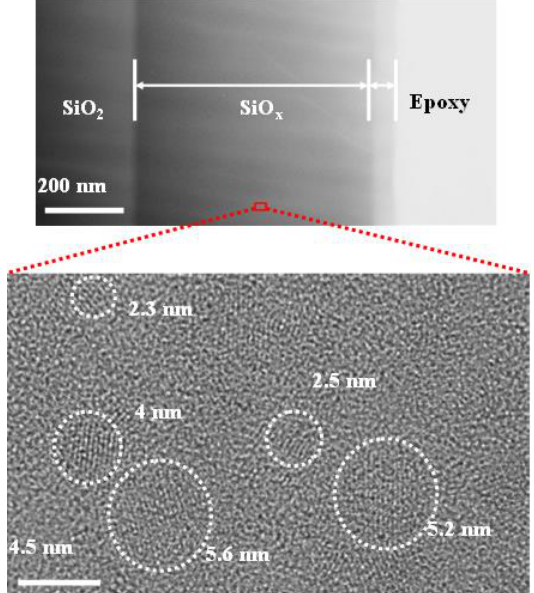
Figure 7. The transmission electron microscopy (TEM) (Upper) and high-resolution TEM (HR-TEM) (Lower) images of plasma enhanced chemical vapor deposition (PECVD)-grown Si-QDs in Si-rich SiO x film.